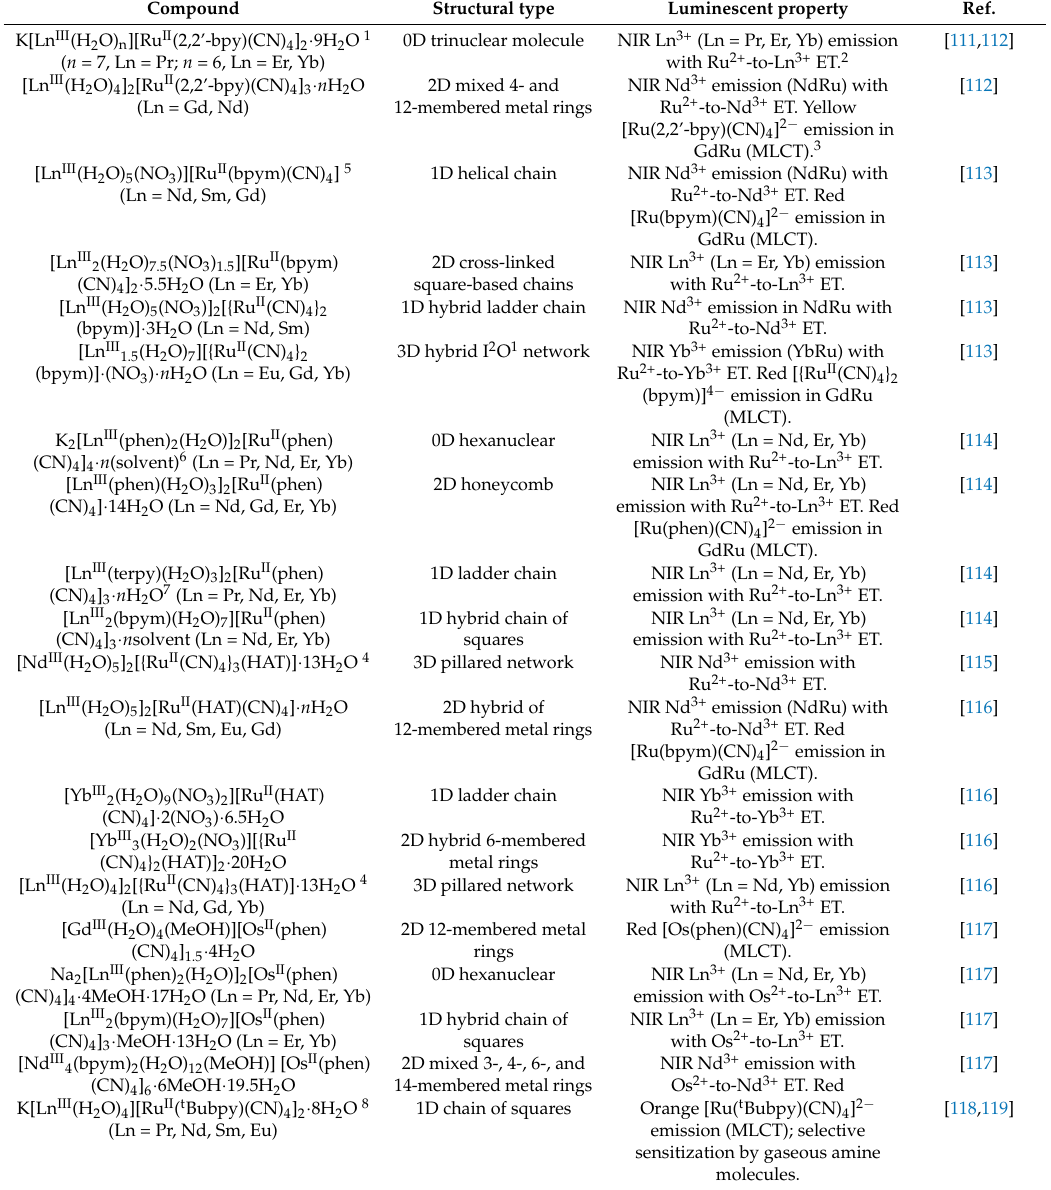
Table 5. Photoluminescent coordination compounds containing lanthanide ions and heteroligand